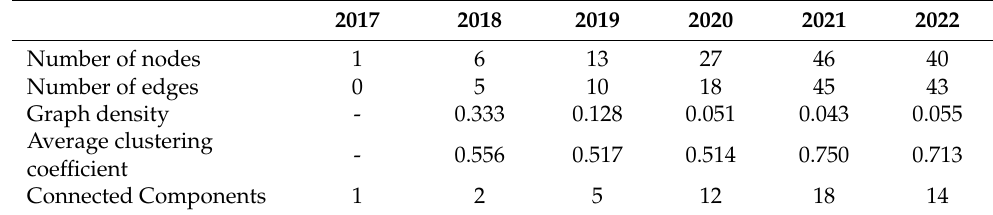
Table 2. Global network measures for the dynamic analysis of the regional network from 2017 to 2022.